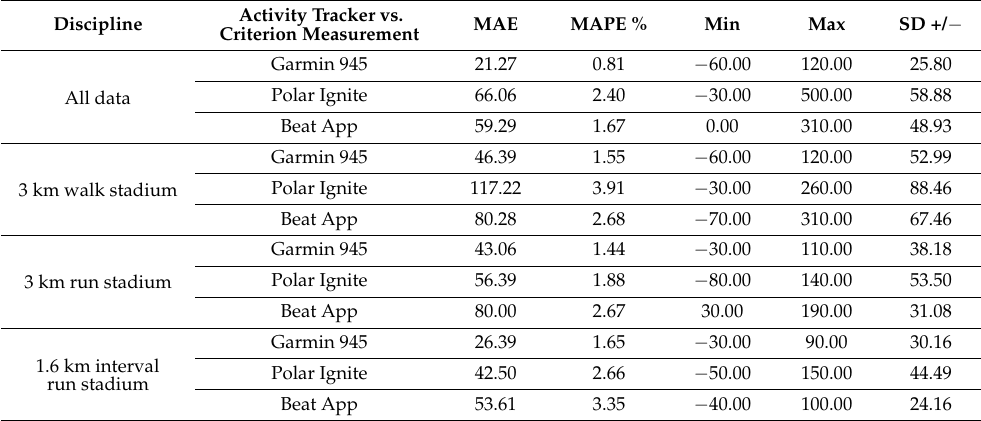
Figure 4. Boxplot of distance deviations from the criterion measurement in the various disciplines ( n = 36). ( a ) p -values compared to criterion and between activity trackers, ( b ) corresponding heart rate graphs, min = minutes. Table 2. Distance measurement deviation calculation, mean absolute error, mean absolute percentage error ( n =